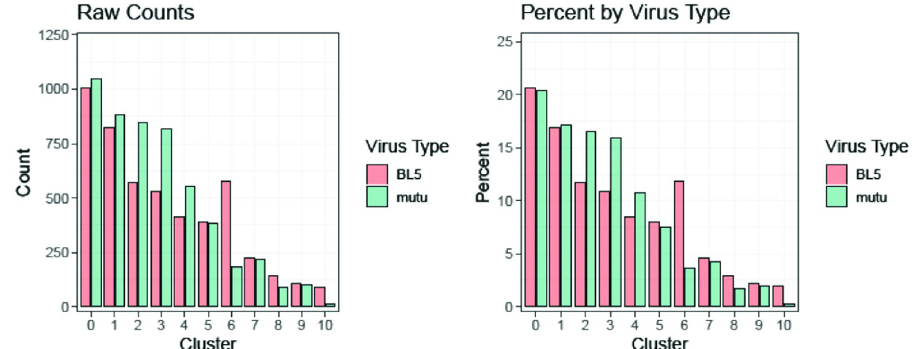
Fig 12. Both T1 and T2 LCLs can be separated into 11 separate clusters in scRNA-seq analysis. 4,879 BL5 and 5,124 Mutu cells analyzed after QC filtering (see Materials and Methods) were distributed across 11 clusters; frequencies of 11 clusters in Mutu and BL5 samples are